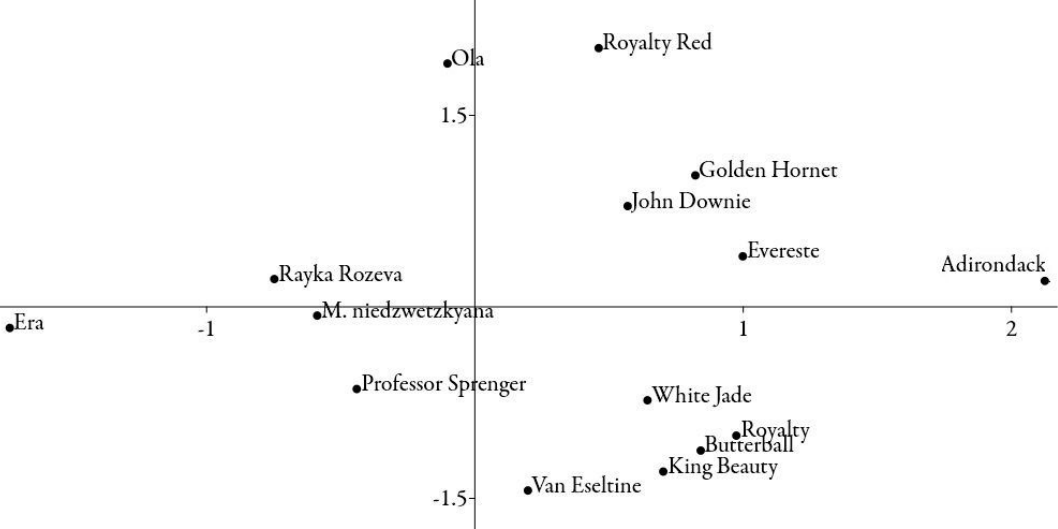
Figure 8. Multivariate analysis performed using correspondence analysis (CA) for the 15 ornamental crabapple cultivars, based on analysed physico-morphological